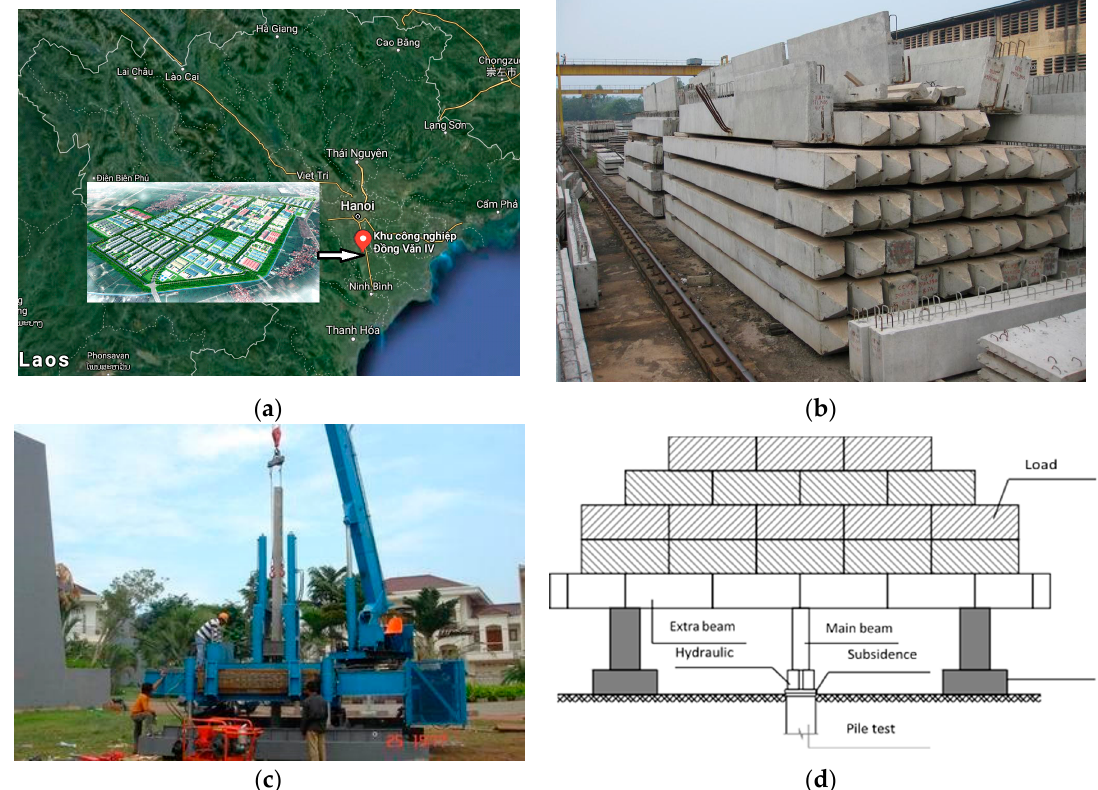
Figure 1. ( a ) Experimental location; ( b ) pre-cast square-section concrete pile; ( c ) hydraulic pile presses machine; ( d ) experimental layout.